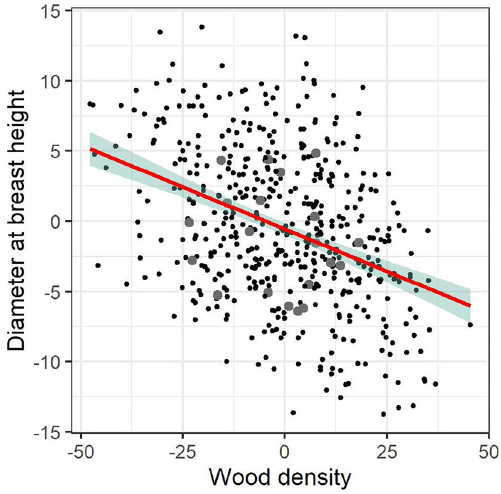
Figure 7. Distribution of individuals regarding their breeding values for DBH and WD; grey points indicate individuals predicted as correlation breakers in population POP2GF.